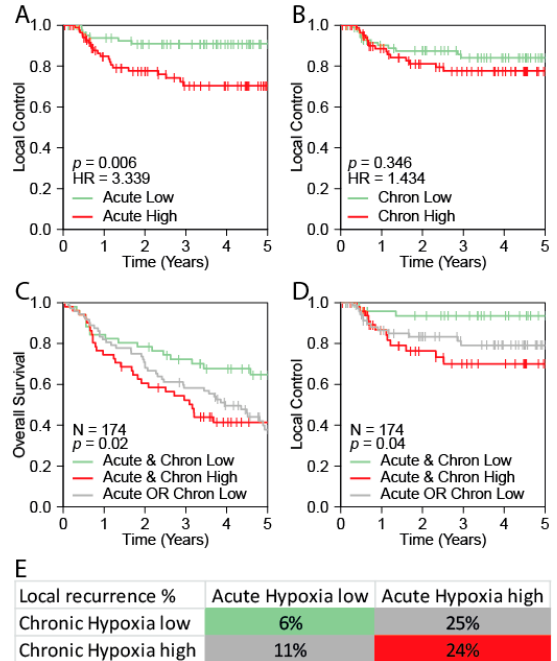
Figure 4. Validation of prognostic value of combined acute and chronic hypoxia scores in the van der Heijden cohort. ( A ) Kaplan–Meier curve showing local control of the “High” versus “Low” acute hypoxia. ( B ) Kaplan–Meier curve showing local control of the “High” versus “Low” chronic hypoxia. ( C ) Kaplan–Meier curve overall survival ( C ) and local control ( D ) for 3 groups: acute and chronic hypoxia both low, acute or chronic hypoxia high or acute and chronic hypoxia both high. ( E ) Crosstab showing the percentage of local recurrences per subgroup in the validation cohort consisting of 174 patients treated with chemoradiotherapy. Cells are colored in a color corresponding with the line color in the Kaplan–Meier curves in panel C and D